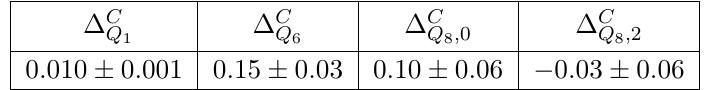
Table 4 . Numerical values for the counterterm